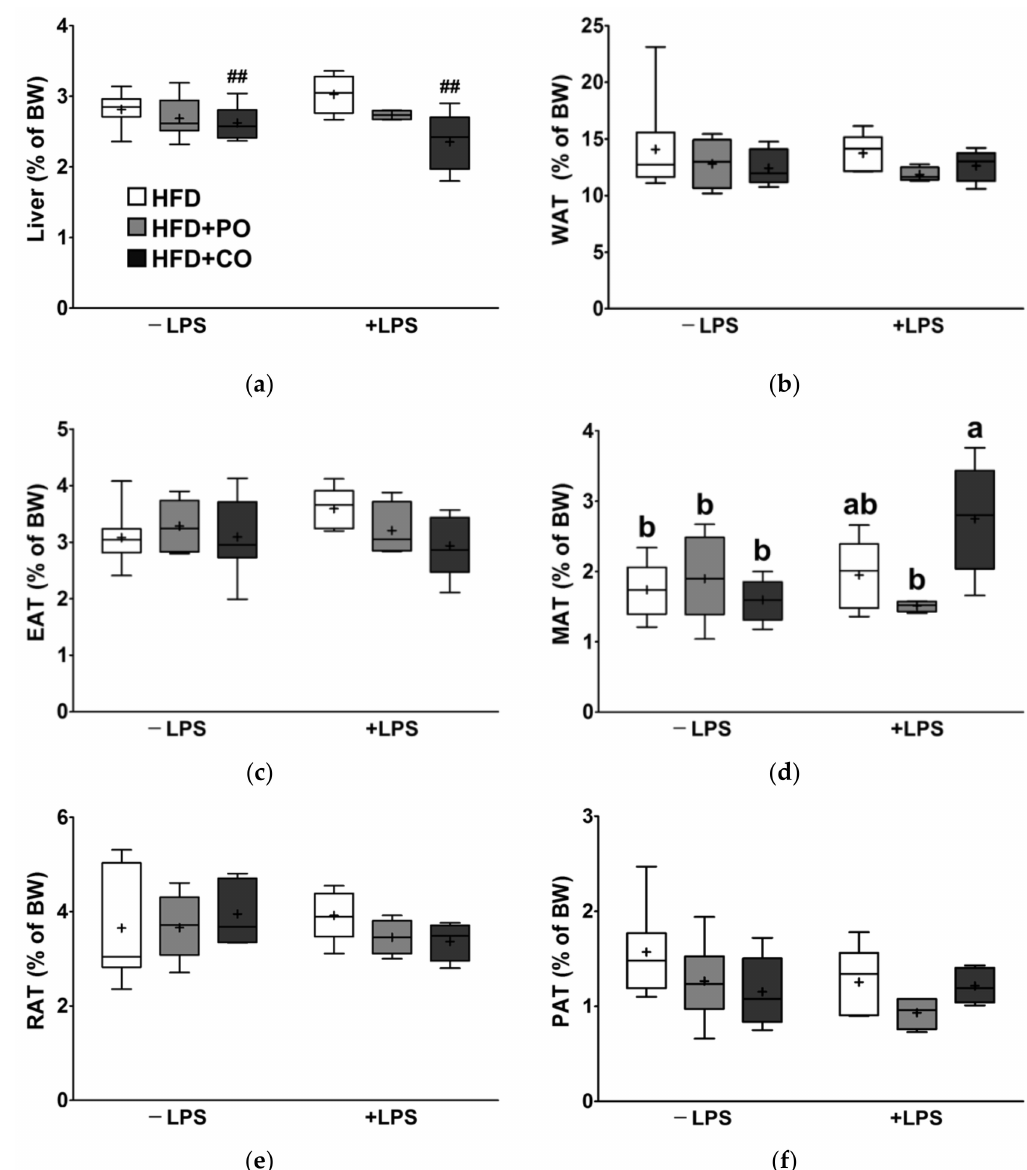
Figure 6. Effects of partial replacement of dietary fat with PO or CO and LPS stimulation on the relative weights of liver and white adipose tissue (WAT). Five-week-old male Sprague-Dawley rats were fed either the HFD, HFD + PO, or HFD + CO for 12 weeks, followed by treatment with PBS or LPS (5 mg/kg) for 24 h ( n = 8 per group). ( a ) Liver weight; ( b ) WAT weight; ( c ) epididymal adipose tissue (EAT) weight; ( d ) mesenteric adipose tissue (MAT) weight; ( e ) retroperitoneal adipose tissue (RAT) weight; ( f ) perirenal adipose tissue (PAT) weight. Data were analyzed using two-way ANOVA and Tukey’s multiple comparisons post hoc test for multiple comparisons. Means with different letters indicate significant differences at p < 0.05. Hash indicates a significant main effect for diet ( ## p < 0.01). LPS, lipopolysaccharide; PBS, phosphate-buffered saline; BW, body